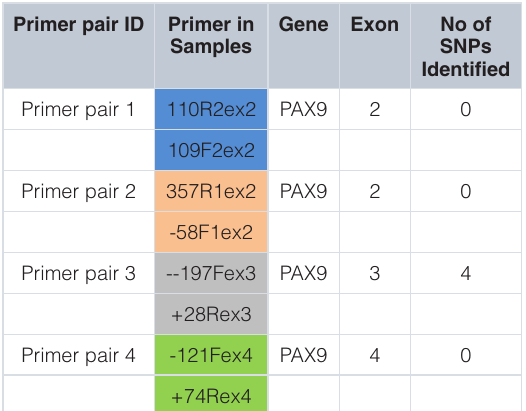
Table 2. SNPs identified according to the primers